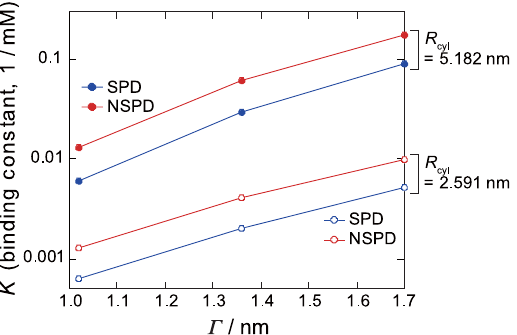
Figure 8. Plot of the binding constants K for both NSPD and SPD with DNA as a function of Γ when R cyl = 5.182 and 2.591 nm. Γ is a parameter to represent the strength of Columbic interaction (see Supplementary